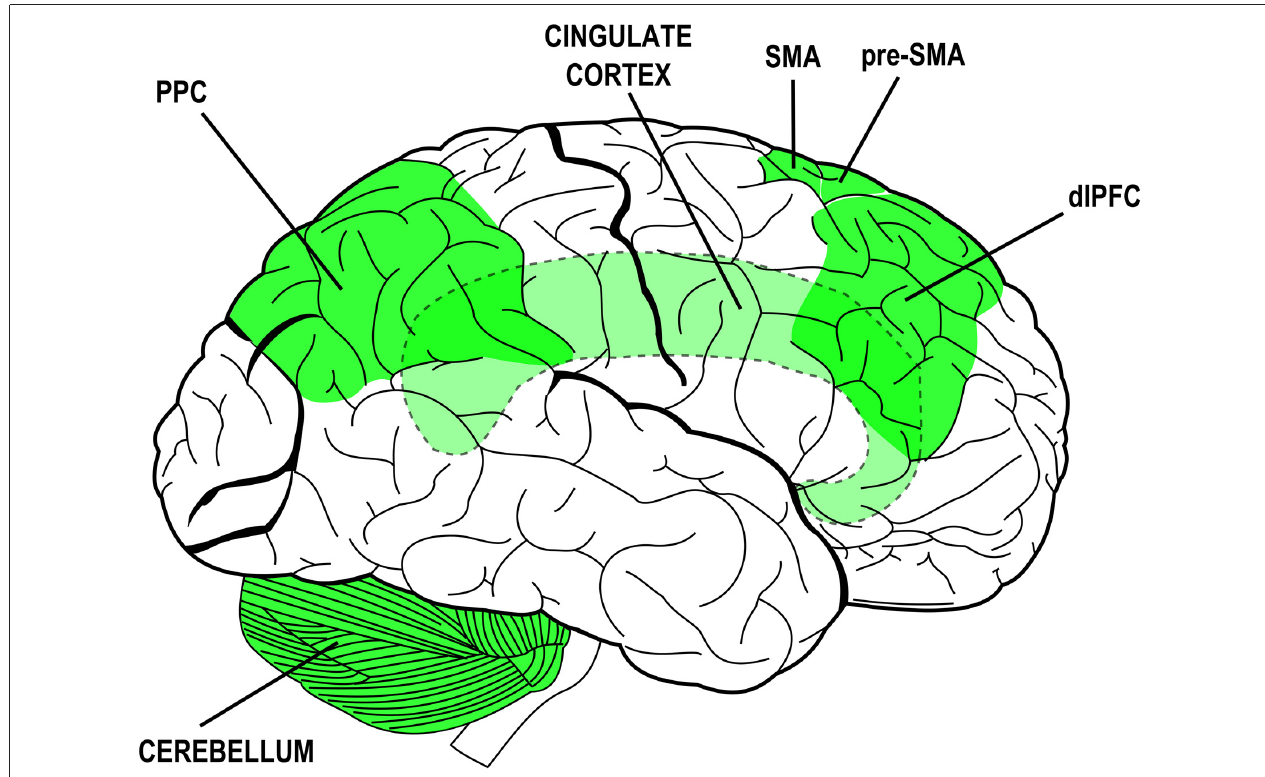
FIGURE 1 | Brain structures associated to functions and processes subserving the experience of agency and their distribution over the brain (lateral view). Simplified schematic representation. Dashed outlines and lighter colors indicate subcortical or hidden structures. PPC, posterior parietal cortex; SMA, supplementary motor area; pre-SMA, pre-supplementary motor area; dlPFC, dorsolateral prefrontal